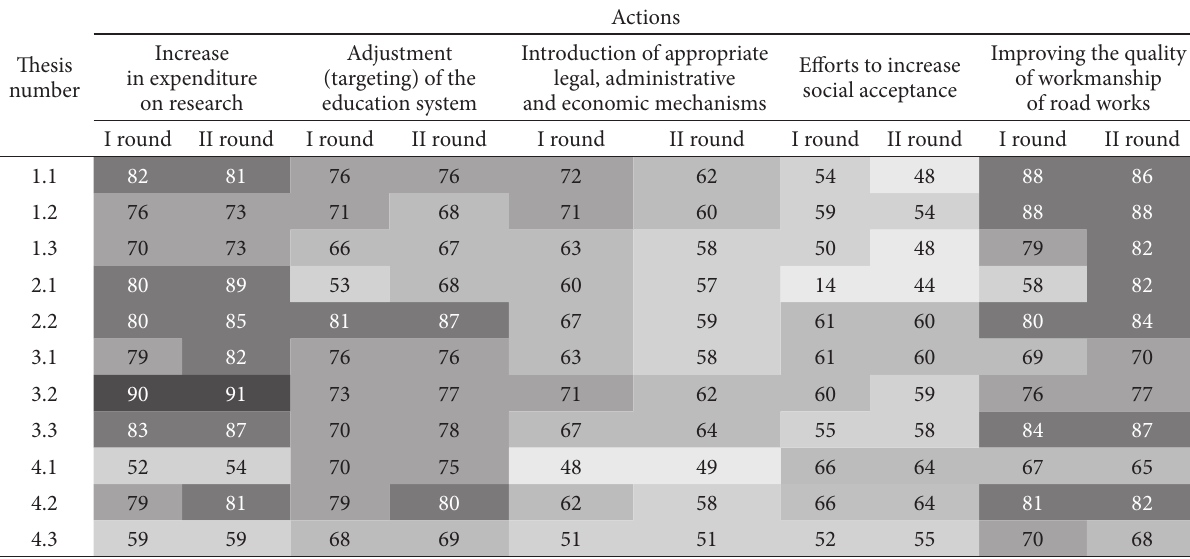
Table 4. Level of influence of particular actions on the realisation of the theses